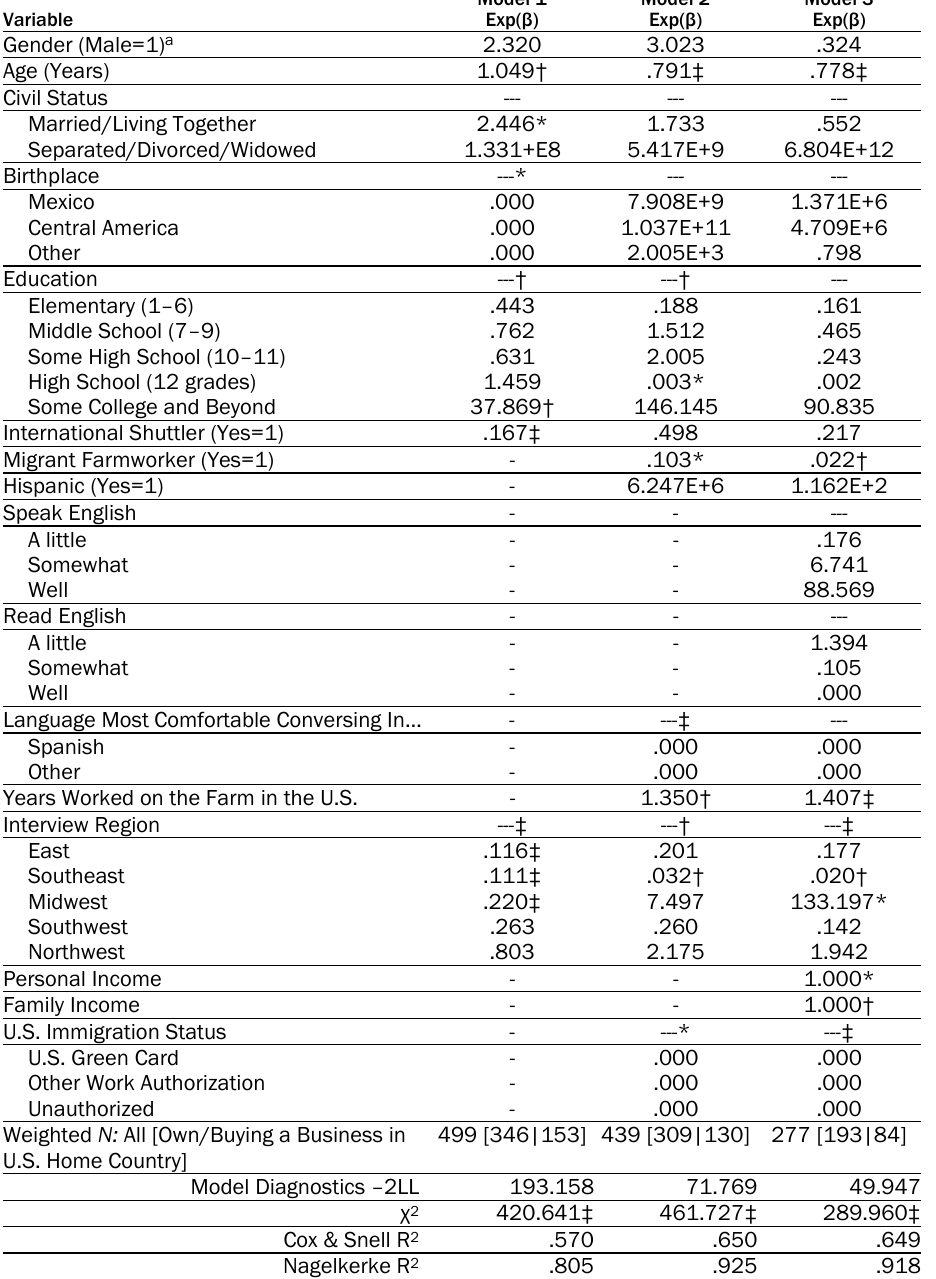
Table 4. Logistic Regression Results (Odds Ratios) for Business Ownership by Country Location (Own business in